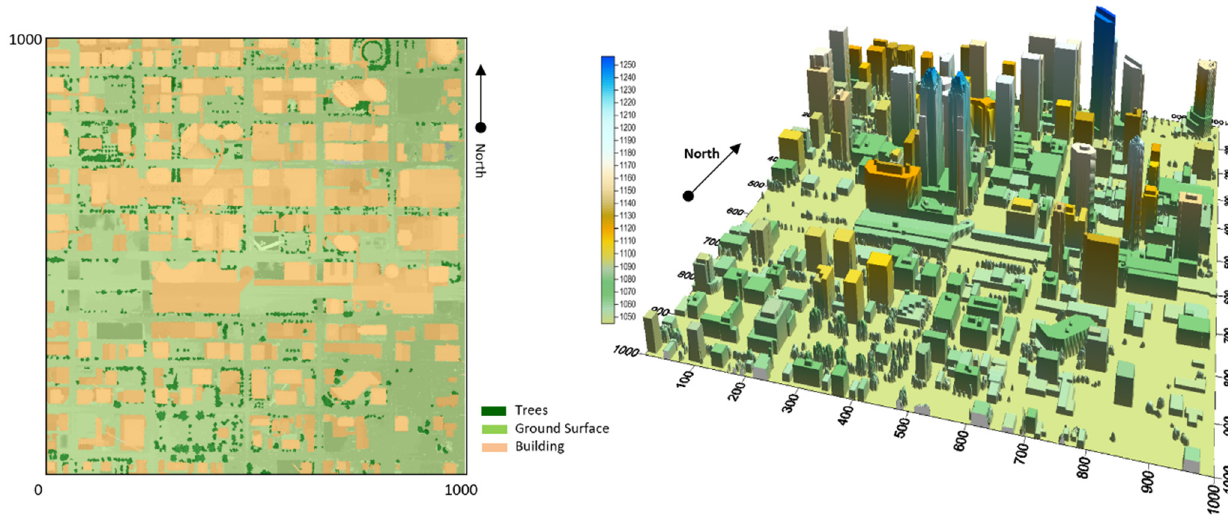
Figure 4. The land cover map ( left ) and modified DSM map ( right ) for testing site of Case B. The scales are in meters.